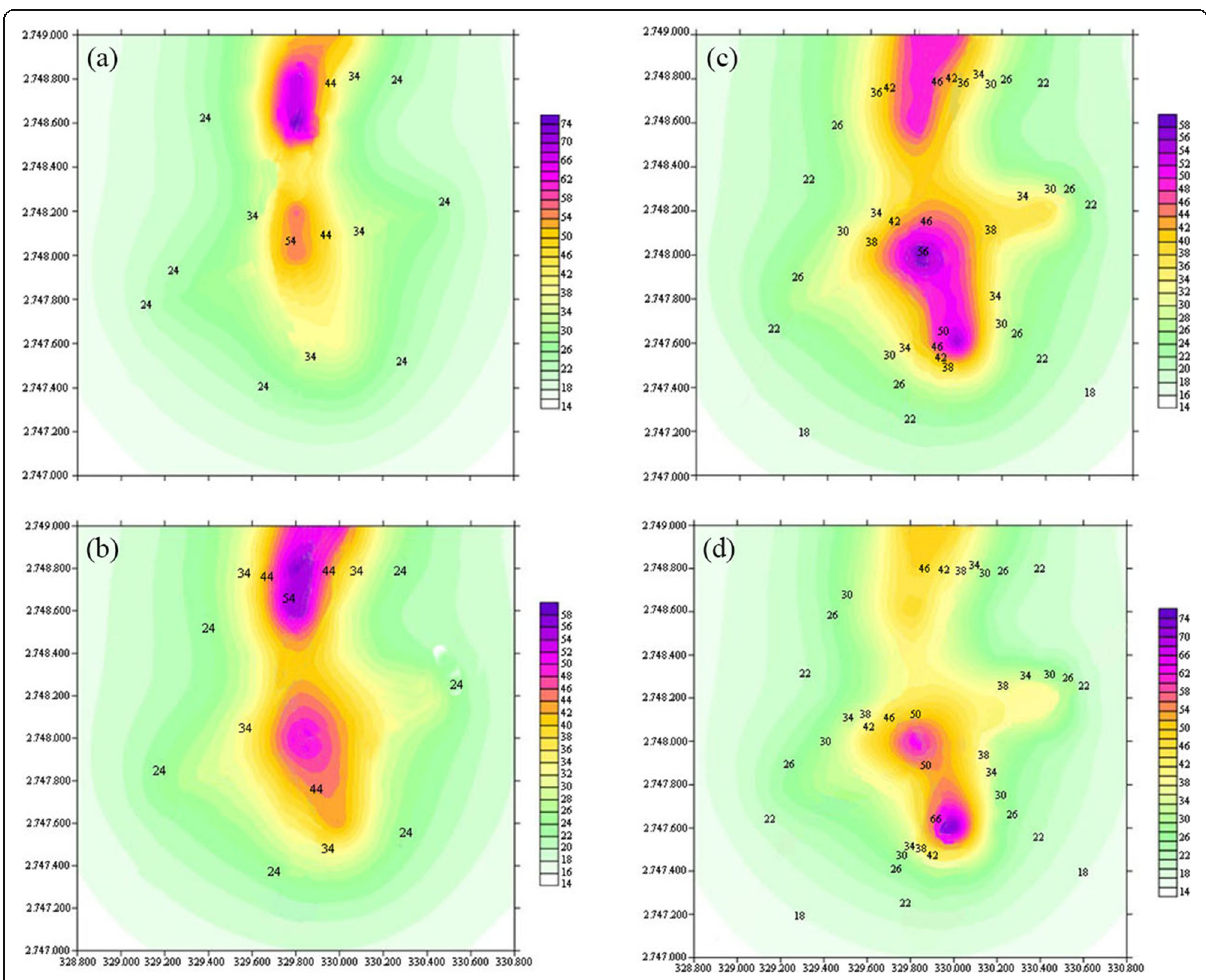
Fig. 7 Simulated hourly concentration of PM 2.5 on the Toucheng highway intersection at ( a ) 9 m; b 7 m; c 5 m; and d 3 m. The x-axis and y-axis are Universal Transverse Mercator coordinate